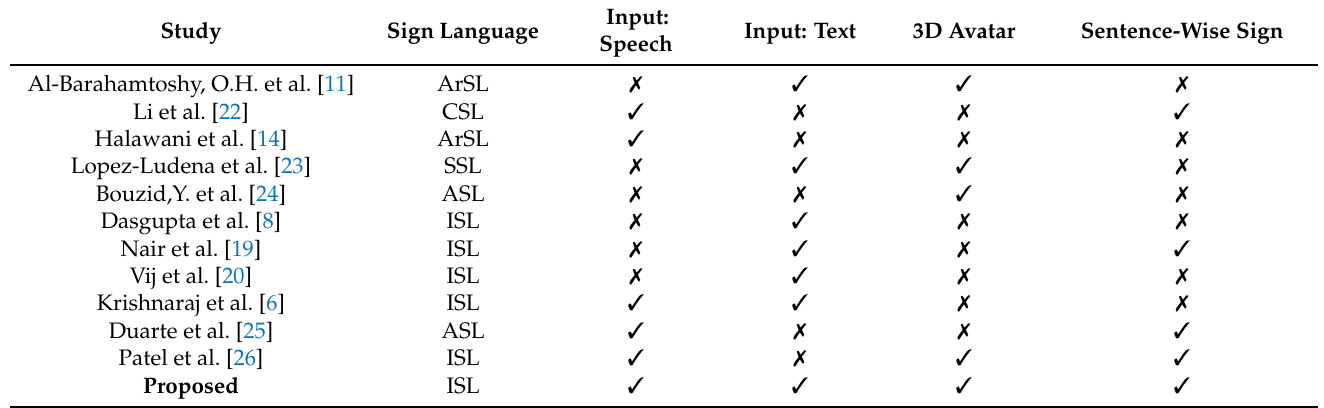
Table 1. Brief description of previous studies of sign language learning systems. Note: Arabic Sign Language (ArSL), Chinese Sign Language (CSL), Spanish Sign Language (SSL), American Sign Language (ASL), and Indian Sign Language (ISL). “Sentence-wise sign” represents the continuous signs corresponding to a sentence in its correspondent spoken